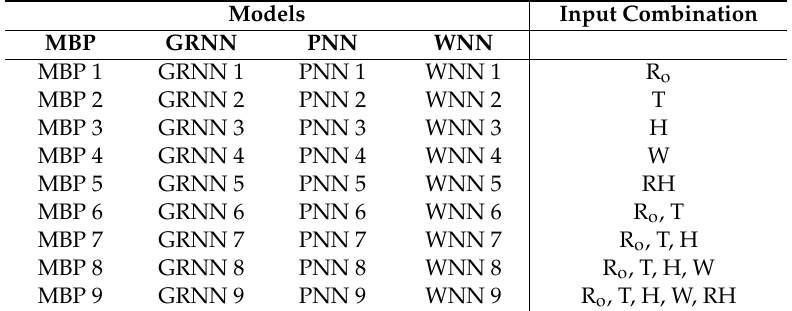
Table 3. The input combination of di ff erent artificial neural network (ANN) models. Models Input